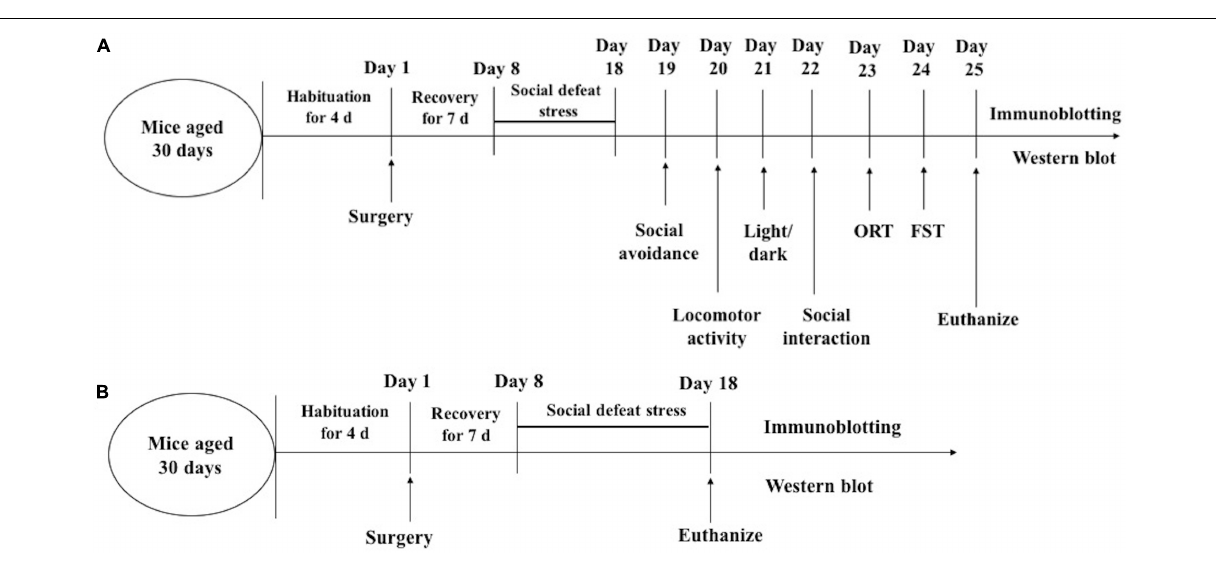
FIGURE 2 | Timeline of experimental procedures. experiment 1 (A) ; experiment 2 (B) . ORT, Object recognition test; FST, forced